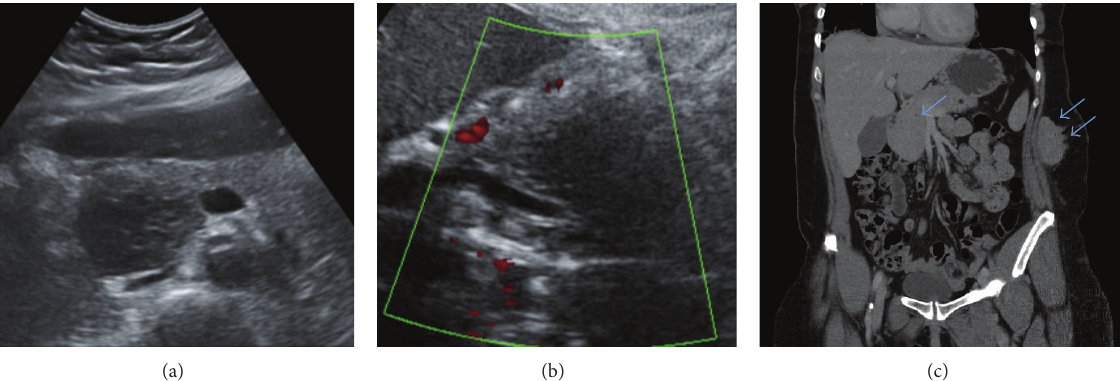
Figure 4: Abdominal ultrasonography and tomography : abdominal ultrasonography showed a hypoechoic, ill-defined, pancreatic mass measuring 49 × 36mm (a). Although the mass affected the pancreatic head, the patient manifested no jaundice. This is justified by the absence of bile duct compression (b). Coronal abdominal CT imaging revealed a solid ill-defined mass in the pancreatic head (single arrow) (c) and another similar lesion in the subcutaneous tissue of the left lateral abdominal wall (double arrows) (c).